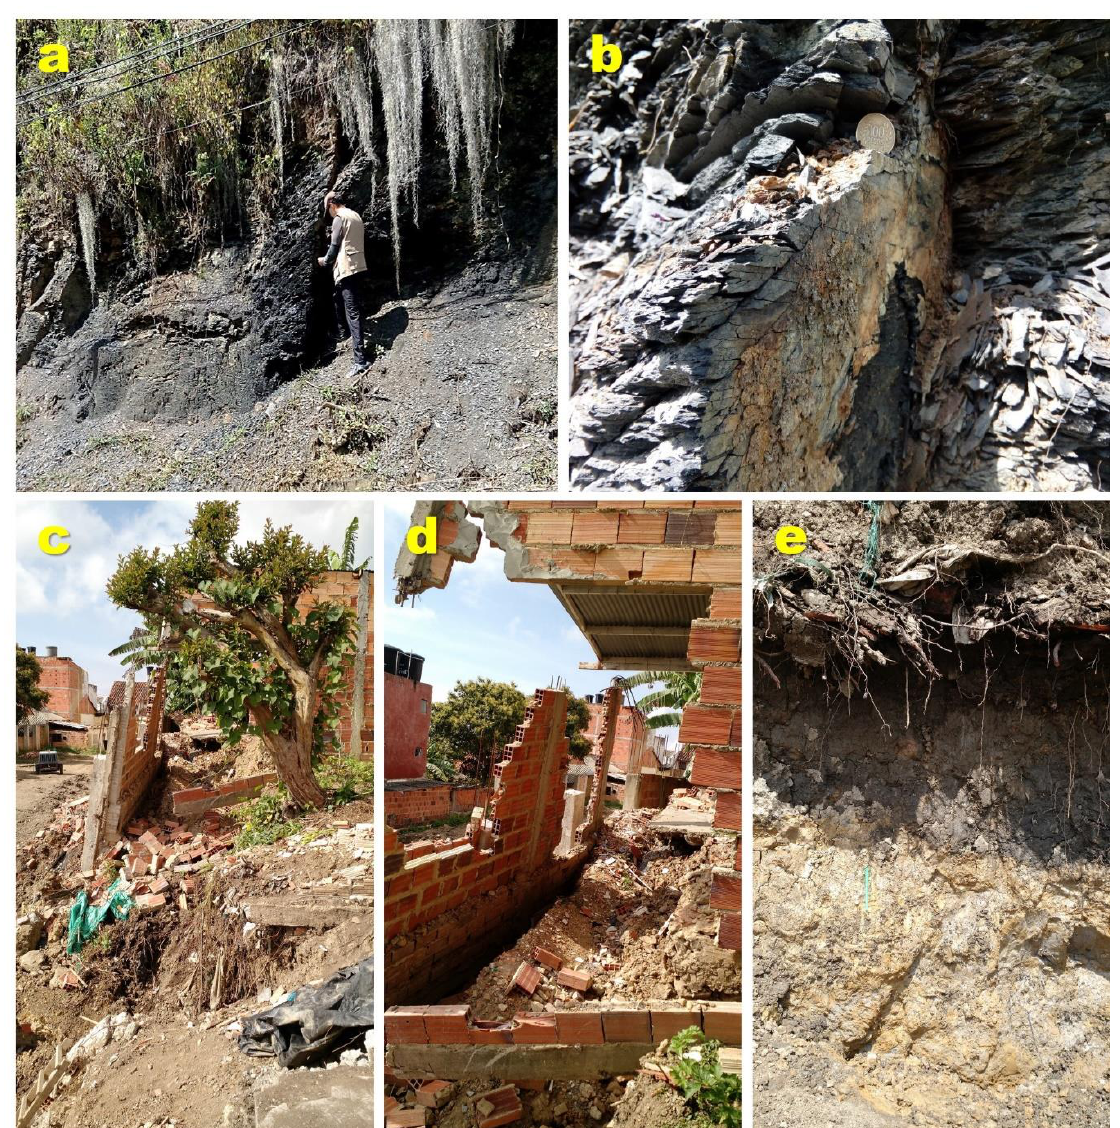
Figure 2. Occurrence of ( a )–( b ) a mudstone outcrop of the Kip3 segment of the Paja Formation along the cutting slope in the San Luis neighborhood, and ( c )–( e ) a regolith of the Kip2 segment of the Paja Formation and excavation in the Las Nieves neighborhood.